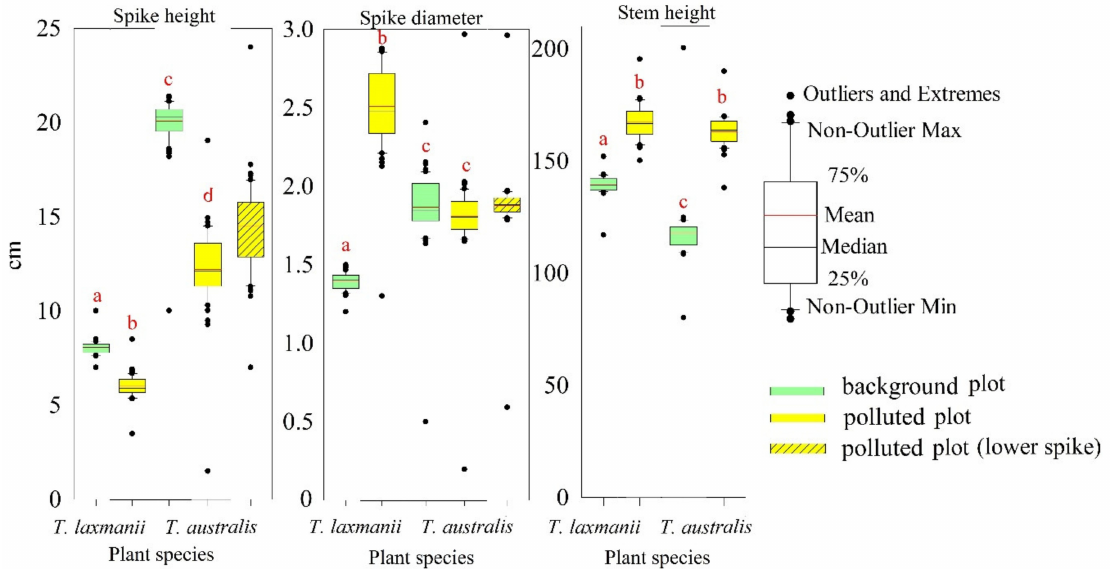
Figure 3. Morphobiometric parameters of T. australis and T. laxmannii growing in the background and polluted plots. Soil pollution resulted in the formation of the lower spike of T. australis (shown by hatching). Different letters indicate significant differences ( p < 0.05) resulting from the post hoc Tukey’s—honestly significant difference (HSD)